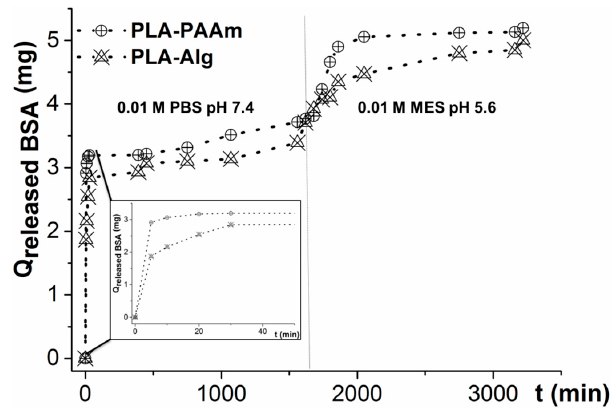
Figure 11. Kinetic curves of BSA release from PAAm and Alg hydrogels on the surface of PLA films. The experiment was performed at pH levels indicated in the figure, at 30 °C with slight stirring (400 rpm).